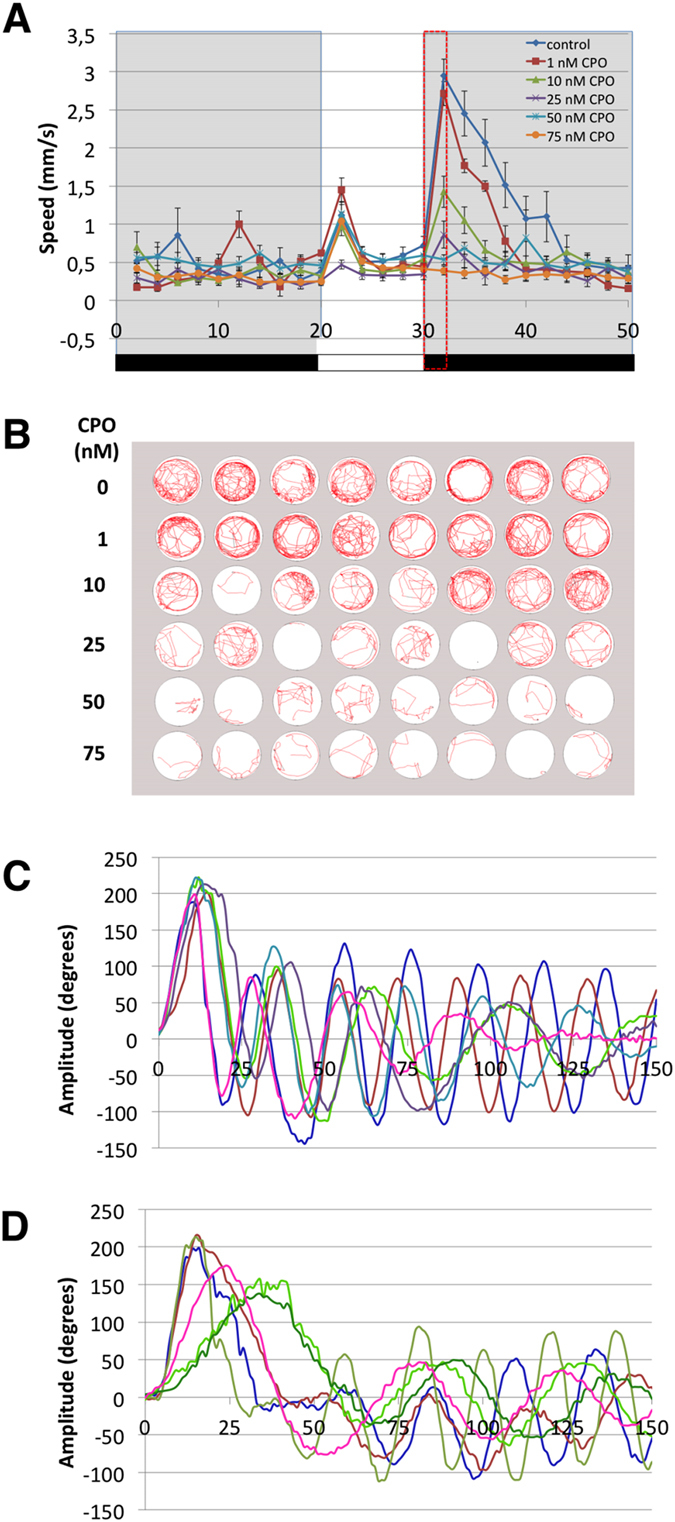
Motor behaviour is strongly impaired by chlorpyrifos-oxon in zebrafish larvae.(A) VMR profiles, showing that the hyperactivity peak evoked in response to sudden exposure to darkness is reduced until total abolition when 8 days post fertilization zebrafish larvae were previously exposed to increasing concentrations of CPO for 24 h. (B) Locomotion tracking plots for the VMR assay in a 48-well behavioural arena (1 larva per well) recorded a decrease in the swimming activity with increasing chlorpyrifos-oxon concentrations during the first 2 min of the light/dark challenge (30–32 min of the assay). (C,D) Kinematics of TMR traces for control (C) and grade 1 (D) larvae. For each condition, six representative traces are shown from the first 150 ms of the escape response. Each trace is from a different larva. The curvature of the body is represented in degrees, with 0 indicating a straight body. Only grade 1 larvae without any morphological defects were selected for behavioural analyses.